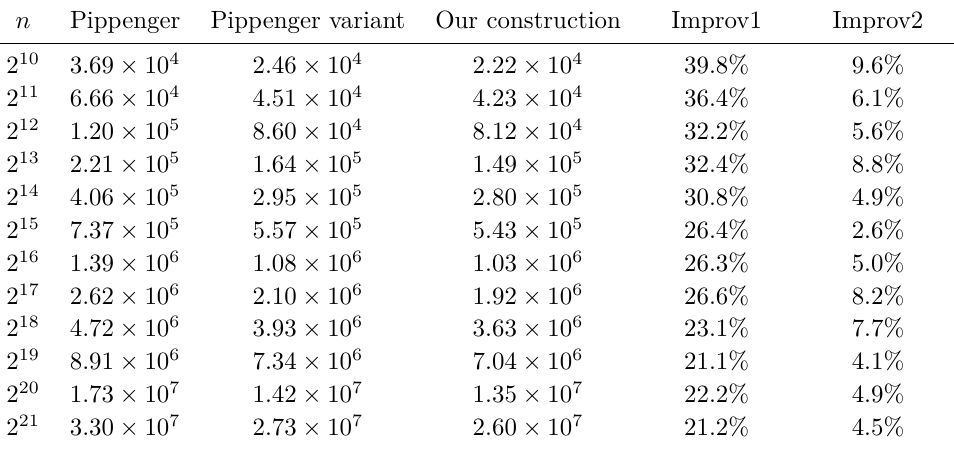
Table 3: Comparison of number of additions taken to compute S n,r in the worst case